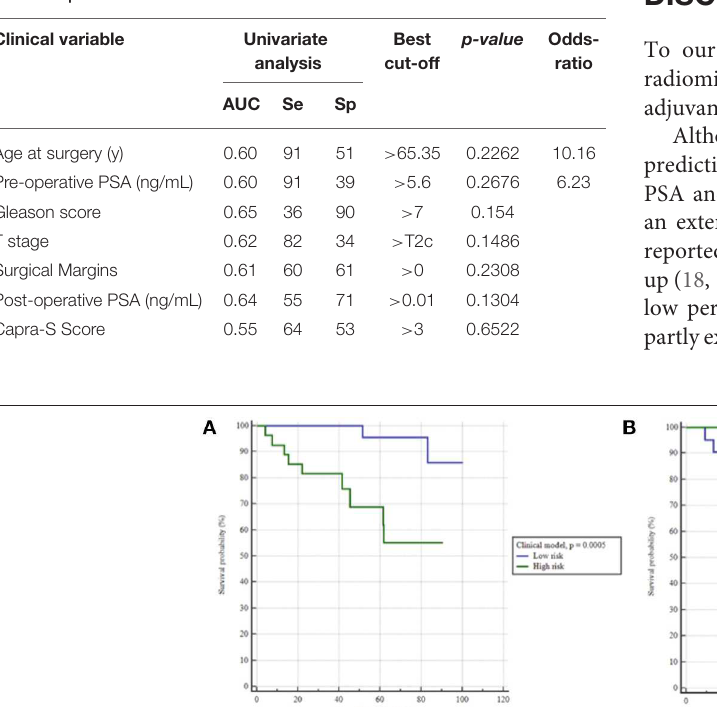
TABLE 3 | Correlation between clinical features and biochemical recurrence.